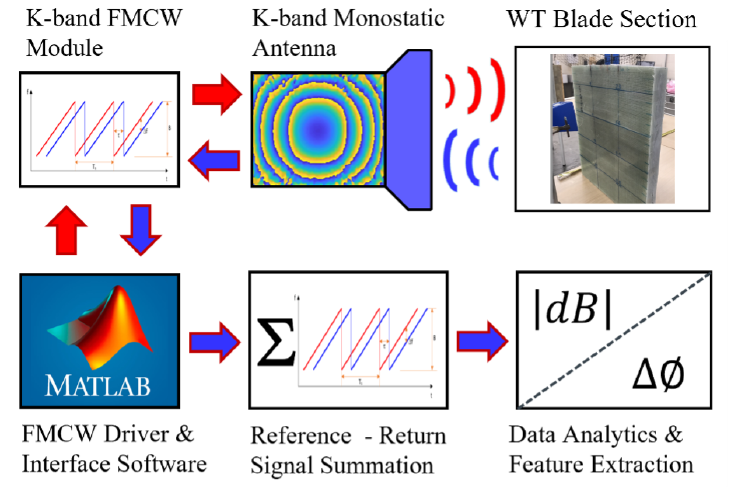
Figure 1. Block diagram of the sensor setup and analytical workflow, where the red (clockwise) arrows indicate the transmitted signal stages and the blue (counter-clockwise) arrows represent the received signal and data processing stages.